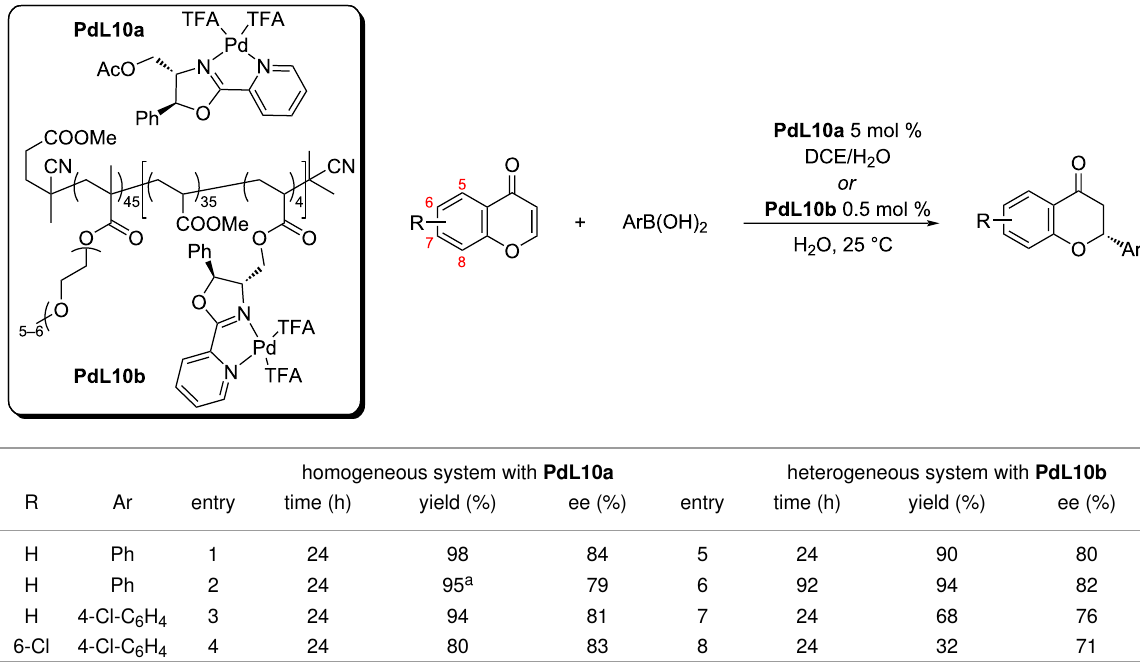
homogeneous system with PdL10a